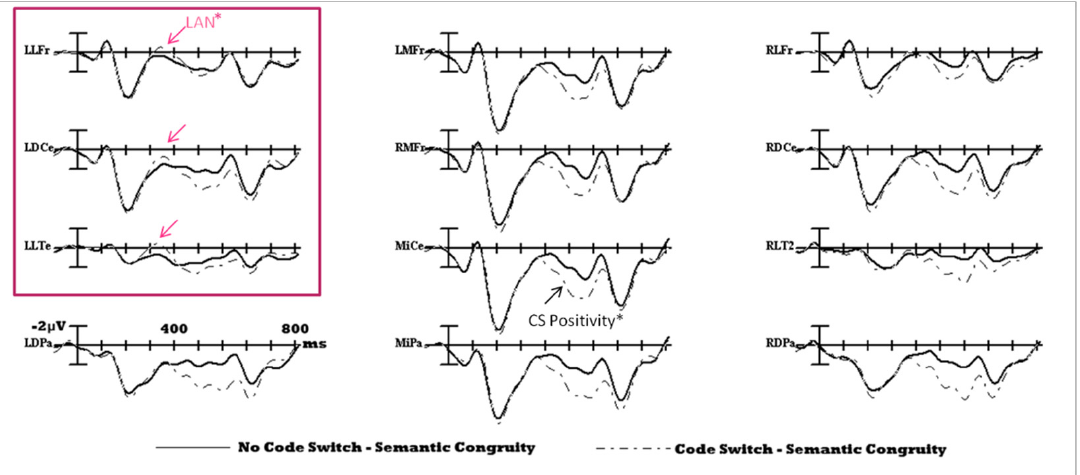
Figure 3. Electrophysiological correlates of codeswitching. A code-switching positivity can be observed from 320–650 ms post stimulus onset. A negativity is also observed over left anterior lateral sites (* p < 0.05).